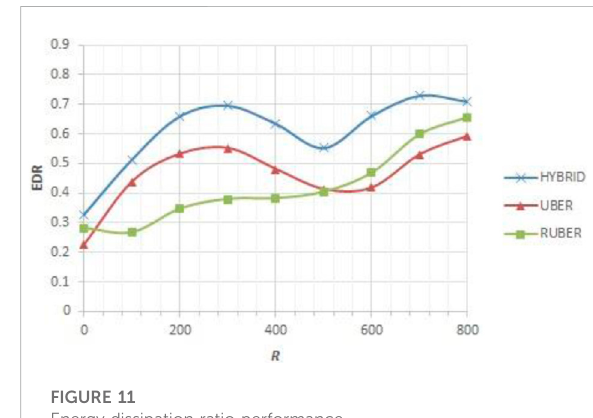
FIGURE 11 Energy dissipation ratio